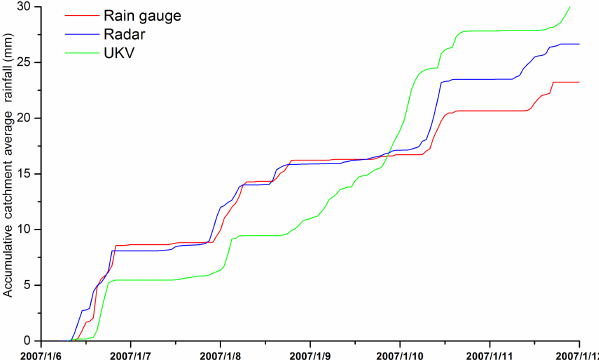
Figure 5. The comparison of accumulative catchment average rain- fall (event January